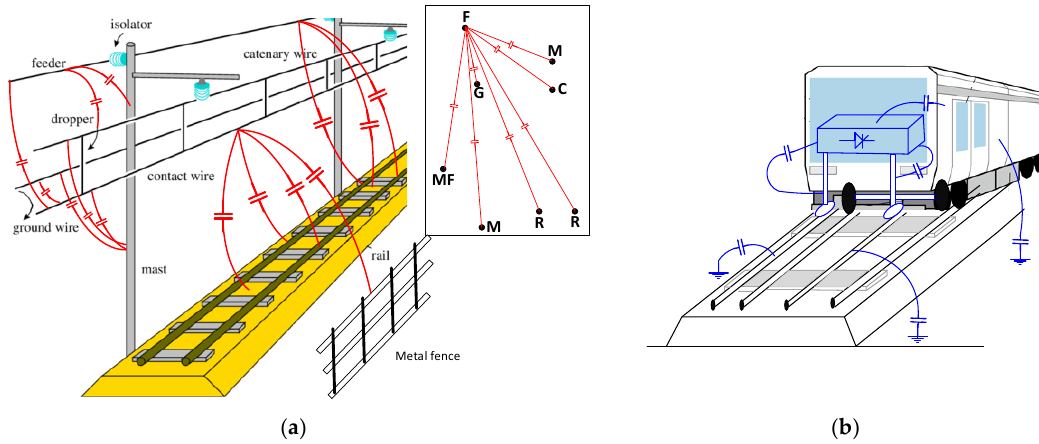
Figure 24. The static and dynamic electrostatic (EEMI) in ERPS. ( a ) Static EEMI. ( b ) Dynamic